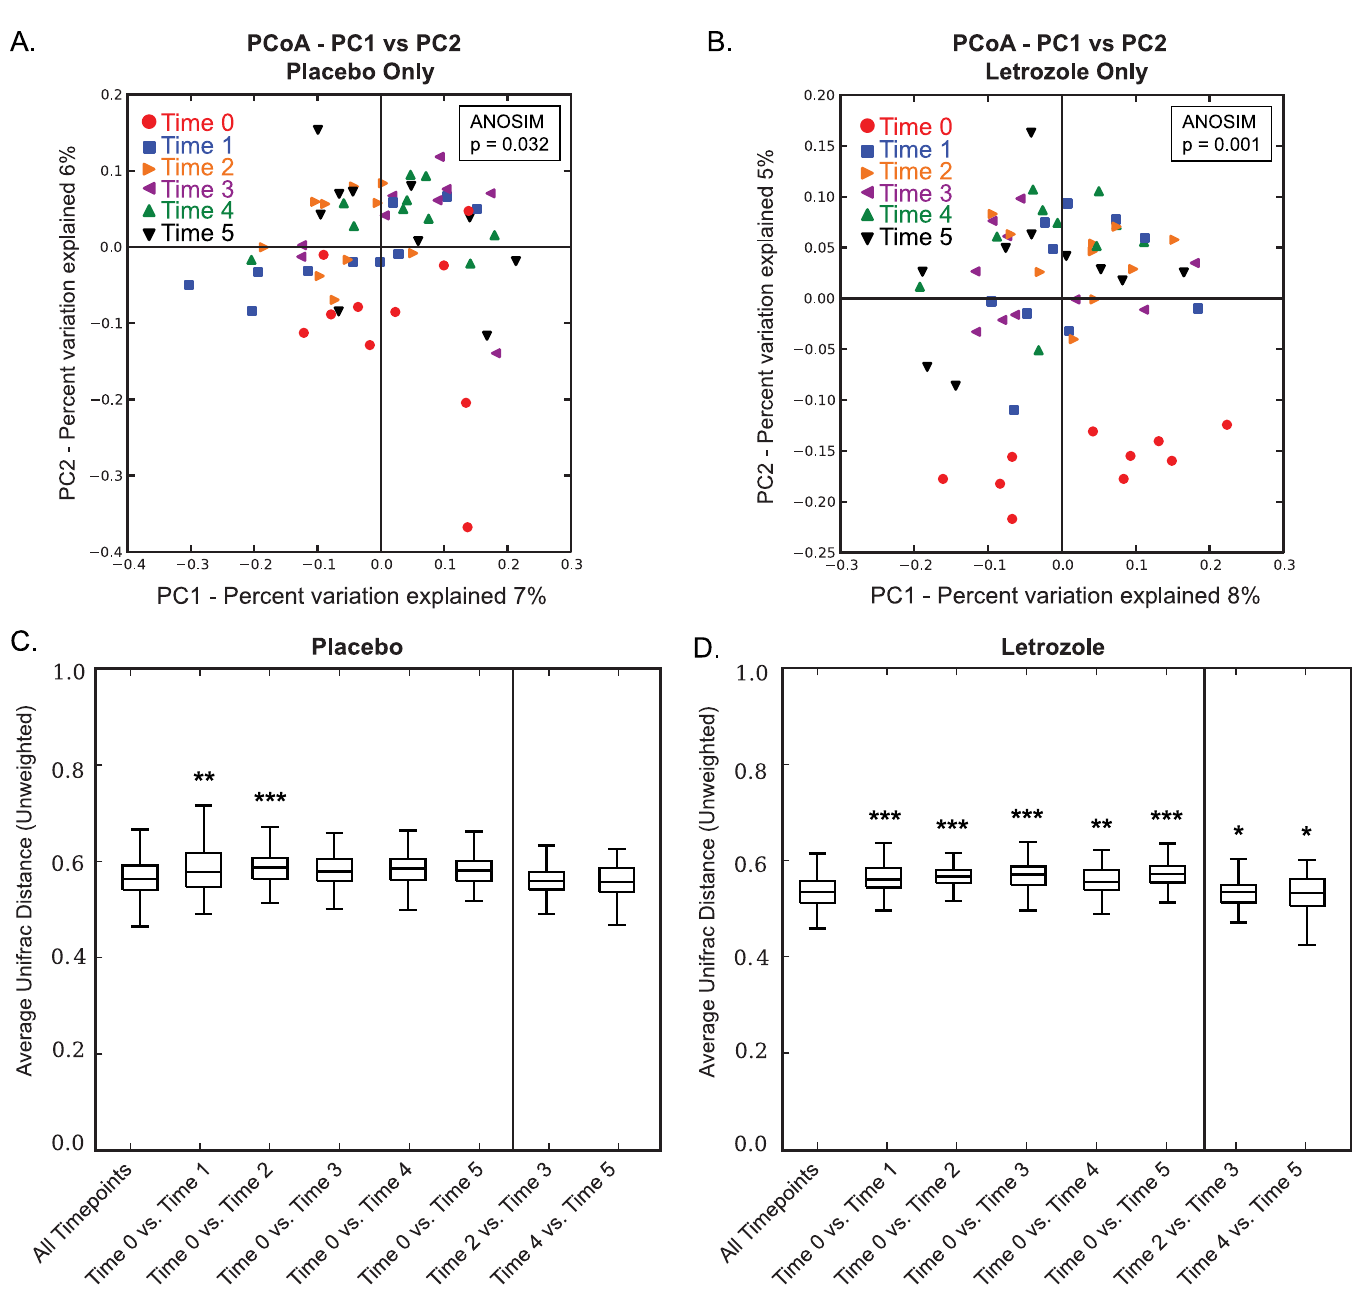
Fig 4. Letrozole results in a shift in beta diversity after one week of treatment. Principle Coordinates Analysis based on unweighted UniFrac distances. Comparison of samples from placebo-treated mice colored by collection time, week 0 – 5 (A). Comparison of samples from letrozole-treated mice colored by collection time, week 0 – 5 (B). Box and whisker plots showing mean and variance of average pair-wise unweighted UniFrac distances between collection time (week) 0 and all other collection time points in the study for placebo (C) and letrozole-treated mice (D). Bars above the graphs indicate when mean differences between time points were significantly different from mean UniFrac distances within all time points, * p < 0.05, ** p < 0.01, *** p <